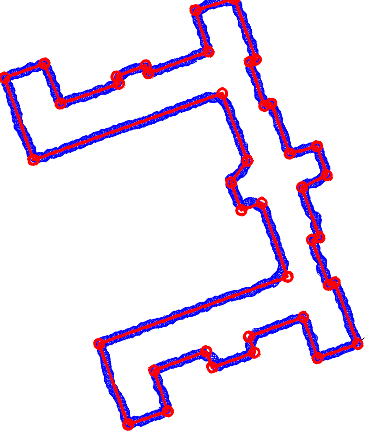
Figure 11. Approximation of polygon obtained using